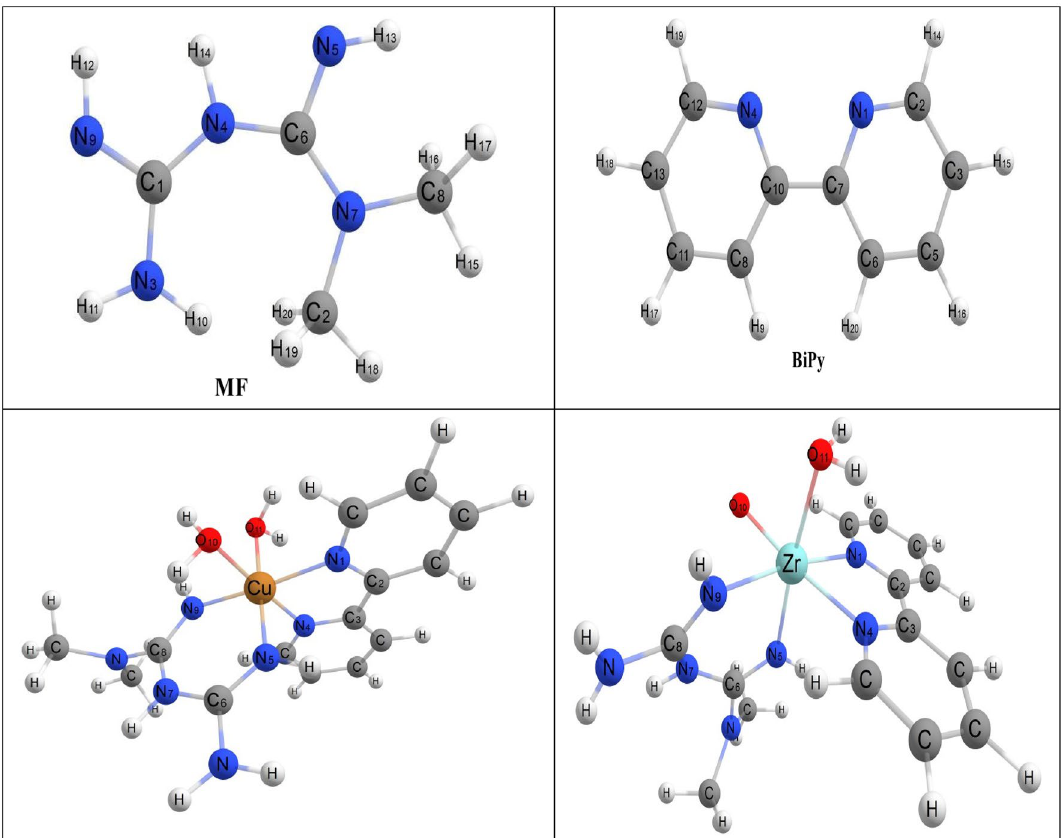
Figure 3. DFT-optimized geometry of MF, Bipy and their metal